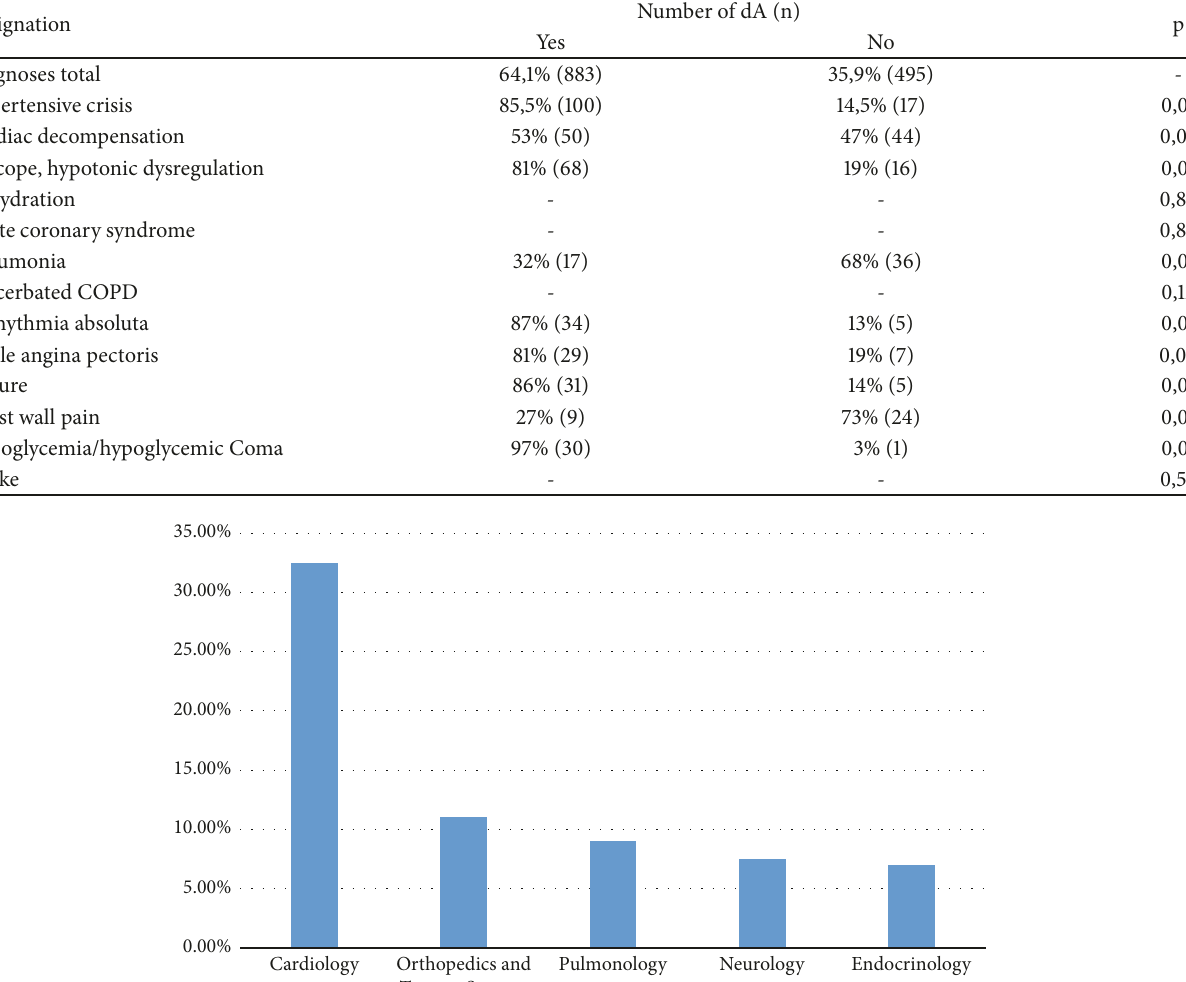
Table 2: Sensitivity analysis of the most common prehospital mission-related hospital discharge diagnoses by the prehospital emergency physician.